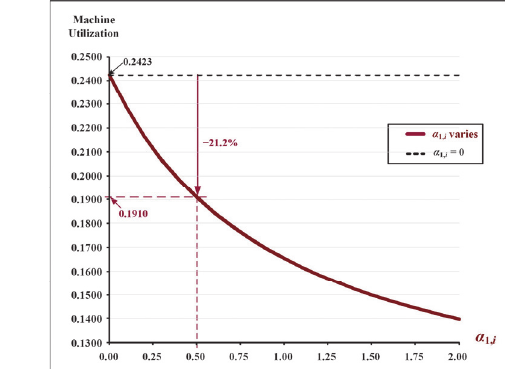
Fig. 8. The influence of overtime (in stage two) on the machine